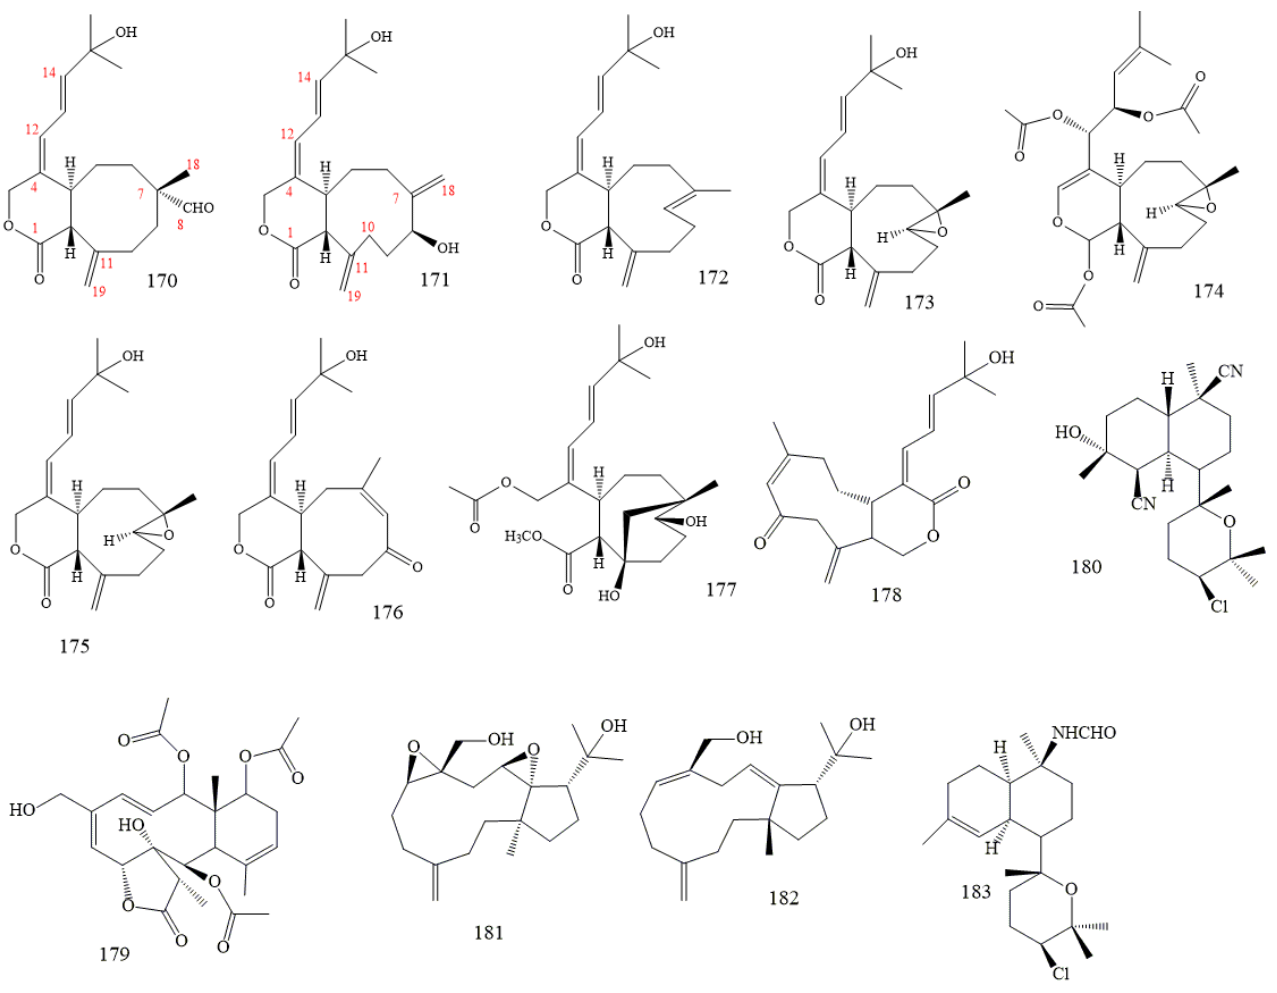
Figure 22. Marine diterpenoids.